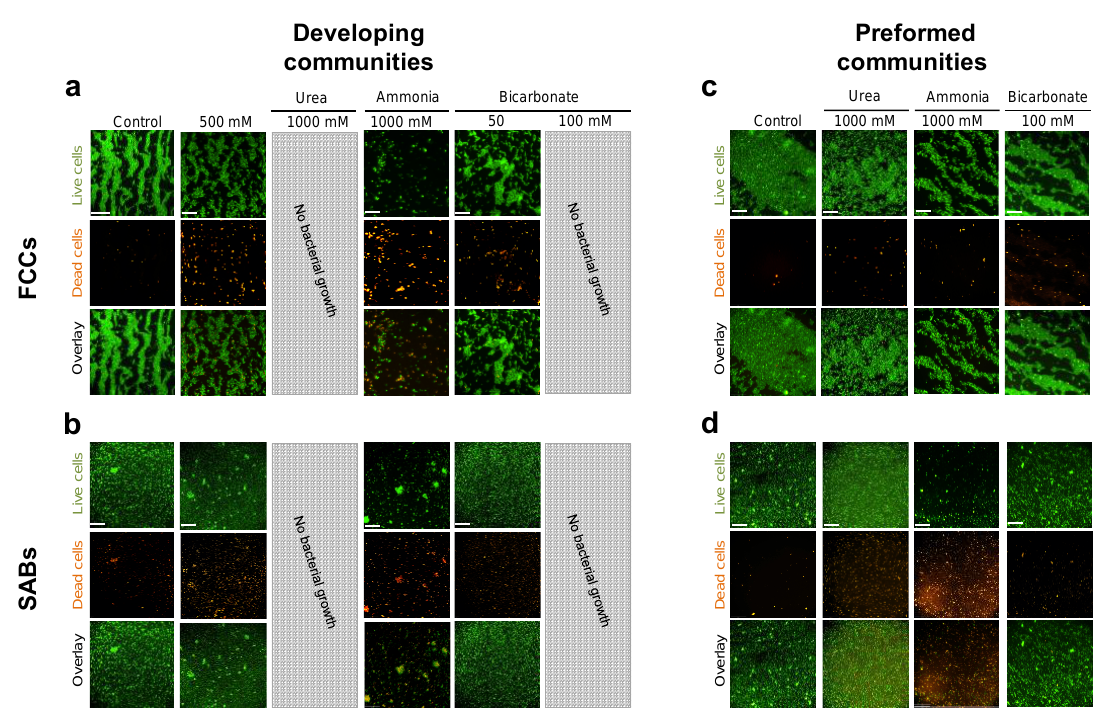
Figure 2. Effect of urea, ammonia and bicarbonate on developing and preformed FCC and SAB. Epifluorescence microscopy was used to monitor FCC ( a , c ) and SAB ( b , d ) formation (‘developing communities’; a , b ) and survival (‘preformed communities’; c , d ) in the presence of various cues. All bacteria are labeled by the permeant DNA stain Syto9 (green channel), but only dead cells are labeled by propidium iodide (red channel). For each condition, an overlay of the two channels is shown. Grey-hatched rectangles indicate concentrations at which bacteria were unable to grow.